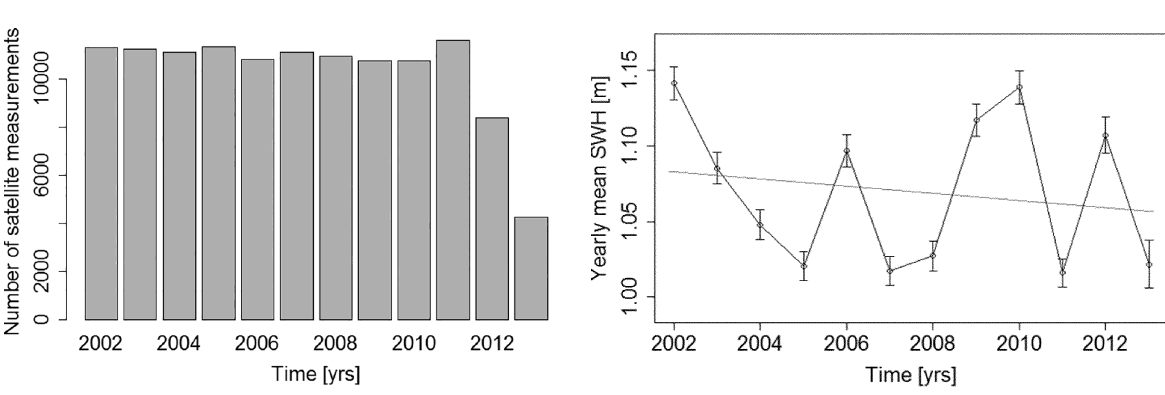
Fig. 8. The number of JASON-1 observations used for each year (left) and the annual mean significant wave height (SWH) in the entire Caspian Sea (right). The solid line shows the linear trend.